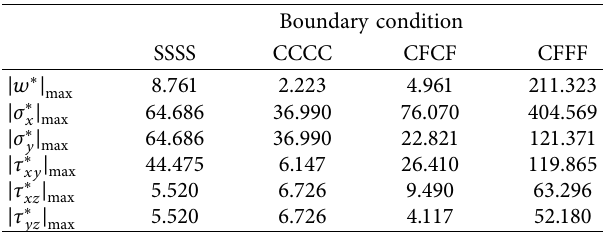
Table 6: Maximum deflection and stress of FGM nanoplate with a hole ( R � a /10) subjected to uniformly distributed load, n � 1, a / h � 10, a / b � 1, and ψ � 1.